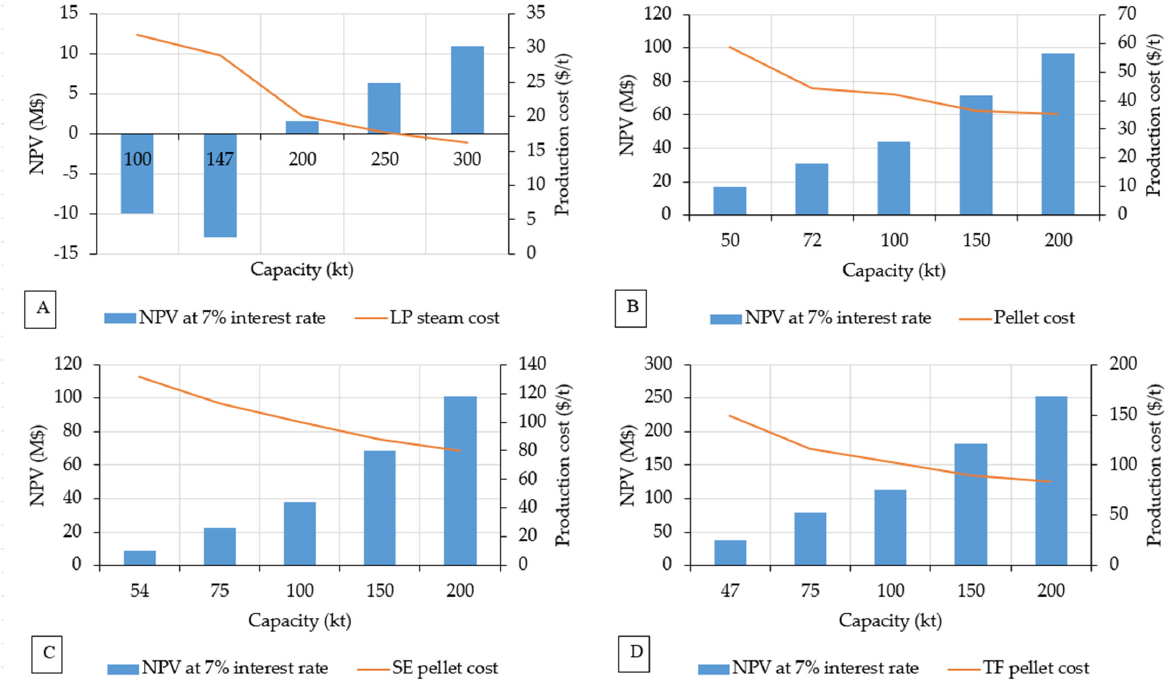
Figure 3. Relationship between net present value and production cost with capacity. SE: steam- exploded, TF: torrefied, LP: low pressure. Scenario 1: direct CHP generation from wood sawdust and shavings ( A ); Scenario 2: wood pellet production without CHP ( B ); Scenario 3: production of pellets and CHP from steam-exploded wood ( C ); Scenario 4: production of pellets and CHP from torrefied wood ( D ).